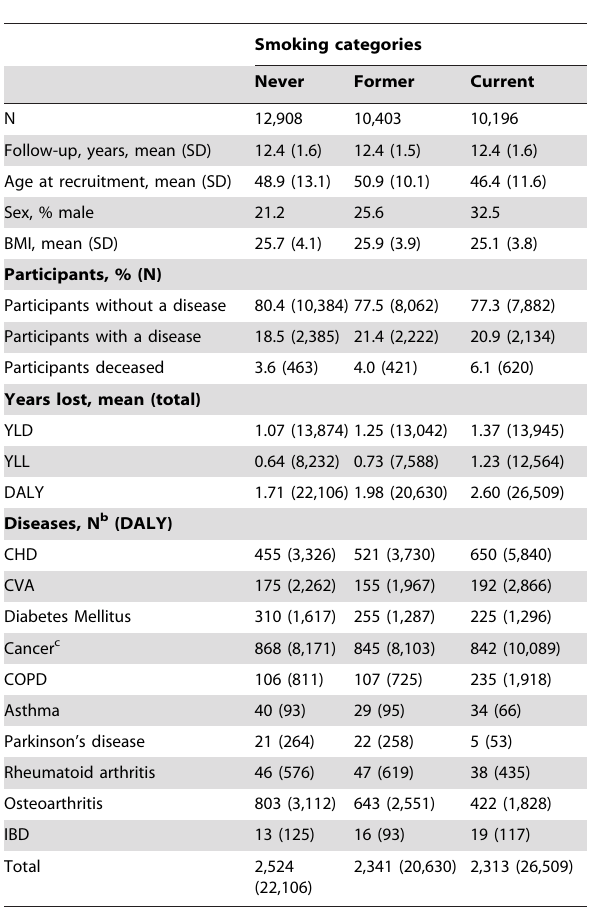
Table 2. Characteristics of 33,507 EPIC-NL participants by smoking status a .